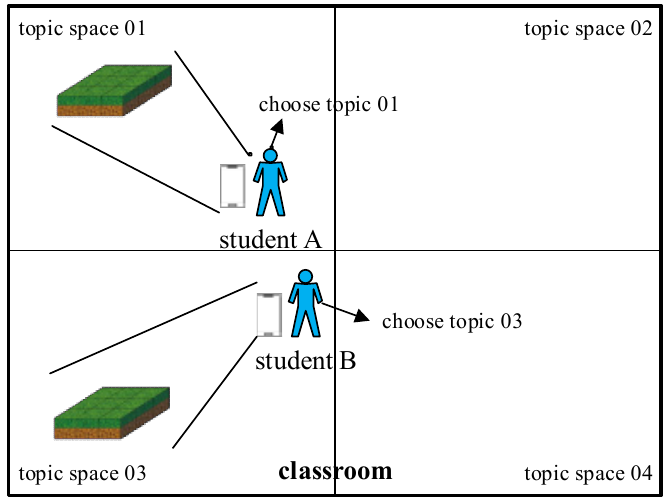
Figure 4. Space concept map taking the classroom as an example.